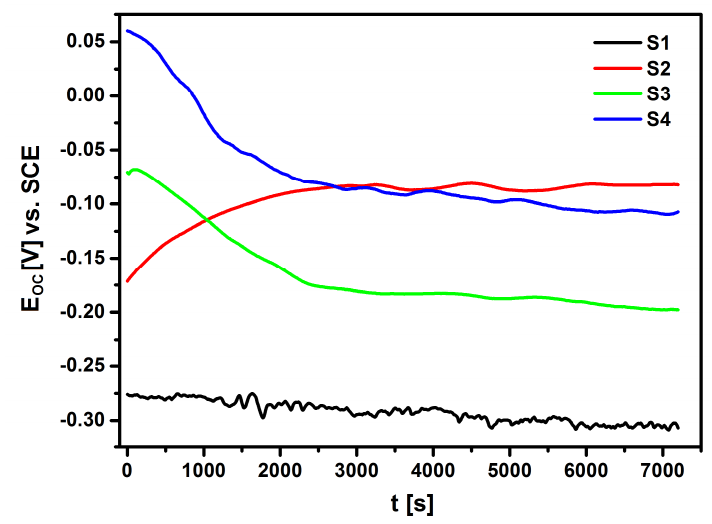
Figure 10. Open circuit potential for the NiTi alloy before and after surface modification in Ringer's solution at 37 ◦ C, where: S1—NiTi alloy after mechanical polishing, S2—NiTi alloy after passivation in a steam autoclave, S3—NiTi alloy after sterilization with a sintered HAp / nSiO 2 / Ag coating (10:1, 40 V / 90 s) and S4—NiTi alloy after sterilization with a sintered HAp / nSiO 2 / Ag coating (5:1, 50 V / 120 s).